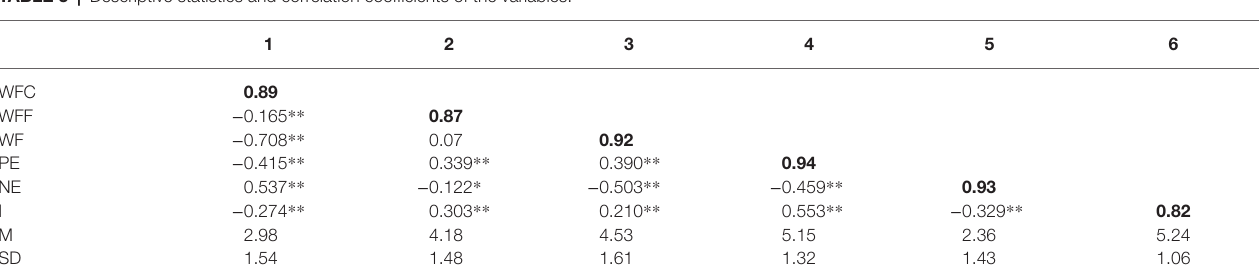
TABLE 3 | Descriptive statistics and correlation coefficients of the